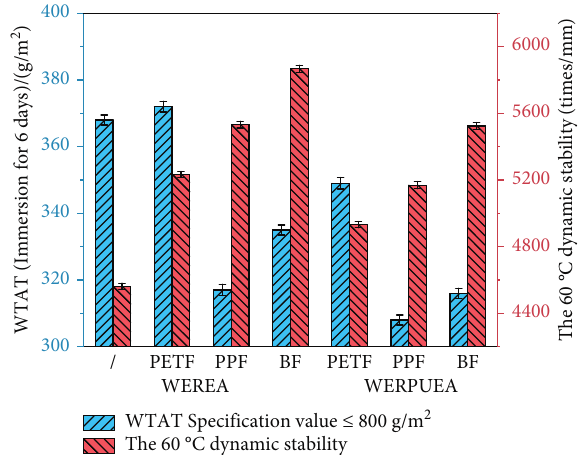
Figure 9: WTAT (immersion for 6 days) and